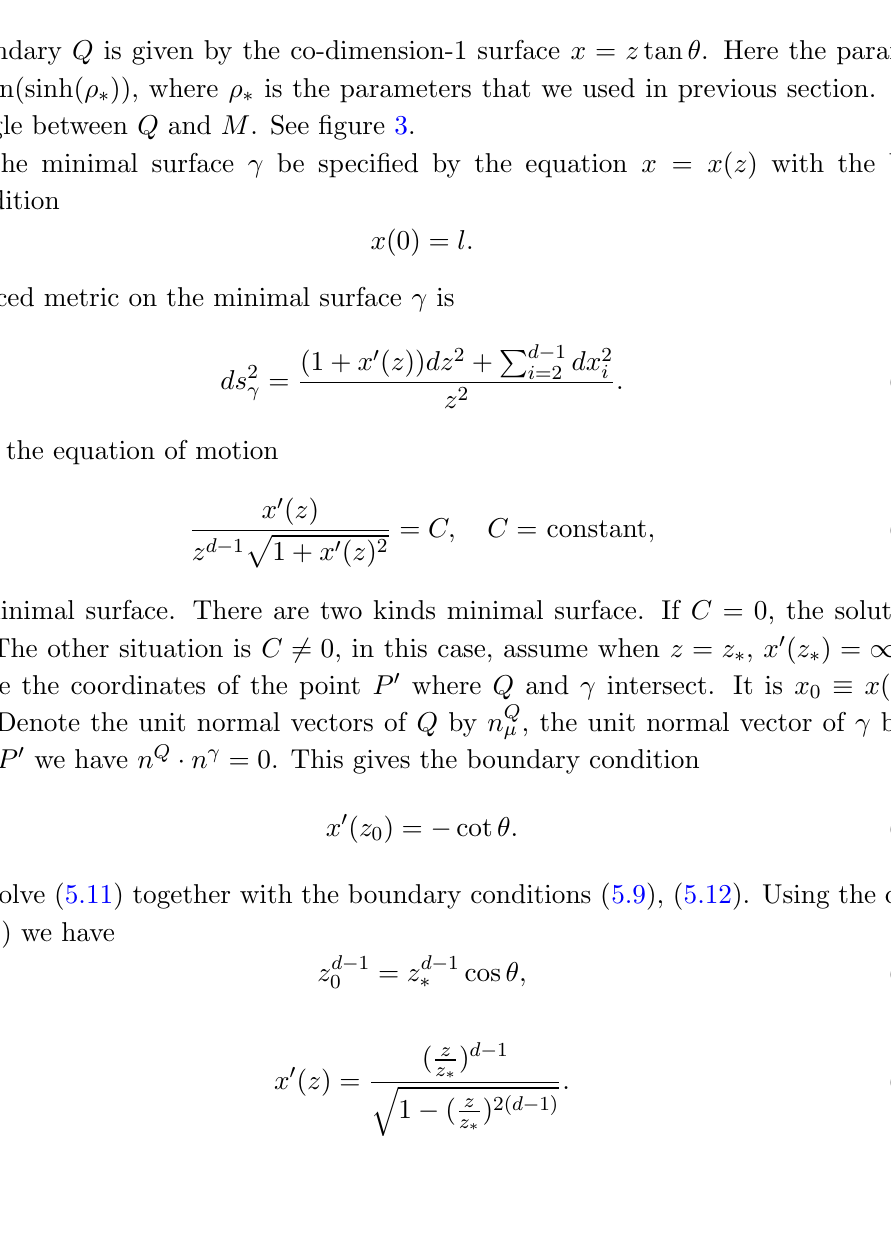
Figure 3 . The minimal surface of